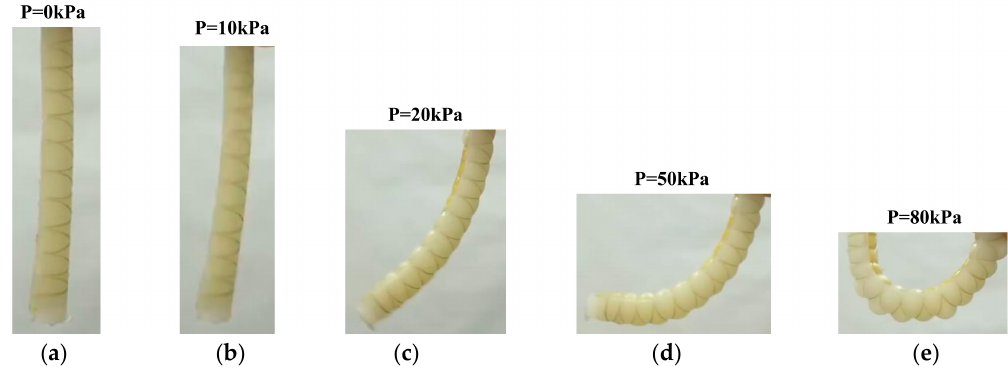
Figure 7. Experiment view of the actuator with different input pressure. ( a ) Bending state. ( b ) State 2. ( c ) State 3. ( d ) State 4. ( e ) State 5.